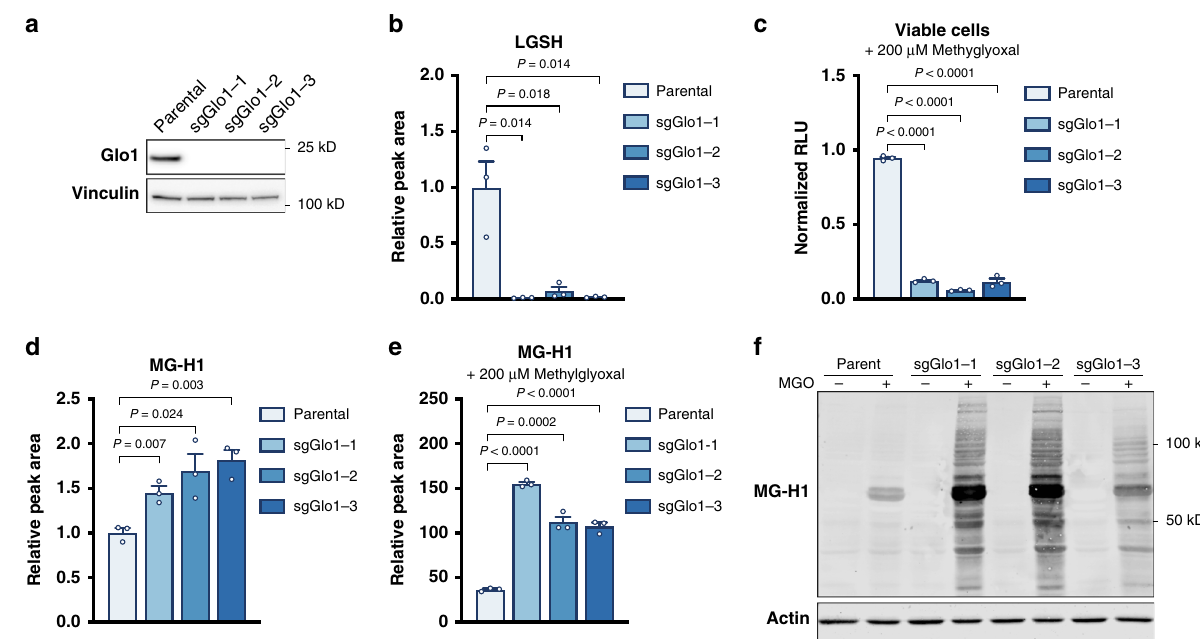
Fig. 4 Glyoxalase I is required for methylglyoxal detoxi fi cation. a Western blot analysis of glyoxalase I (Glo1) expression in parental 3553T3 lung cancer cells and in three independent clones where the Glo1 gene was disrupted using CRISPR/Cas9 (sgGlo1). b Relative levels of lactoylglutathione (LGSH) in 3553T3 parental NSCLC cells or the Glo1-deleted clones described in ( a ) as detected using LCMS. Values shown are the peak area of LGSH normalized to the peak area of GSH ( n = 3). c Relative number of viable 3553T3 parental cells and Glo1-deleted clones as determined by CellTiter-Glo Luminescence Assay following a 48-h incubation with 200 μ M methylglyoxal ( n = 3). d LCMS quanti fi cation of relative free MG-H1 abundance in 3553T3 parental cells and Glo1-deleted clones. Values are peak area of MG-H1 normalized to peak area of arginine ( n = 3). e LCMS quanti fi cation of free MG-H1 abundance in extracts from 3553T3 parental cells and Glo1-deleted clones that were incubation with 200 μ M methylglyoxal for 16 h. Values are normalized to MG-H1 peak area in parental lung cancer cell lines incubated without methylglyoxal treatment shown in panel ( d ), which were analyzed in the same LCMS experiment ( n = 3). f Western blot analysis using an antibody raised against the MG-H1 epitope of lysates from 3553T3 parental cells and Glo1-deleted clones that had been treated without or with 200 μ M of methylglyoxal for 12 h. Values in b – e denote mean ± SEM and the P values were calculated by unpaired, two-tailed t